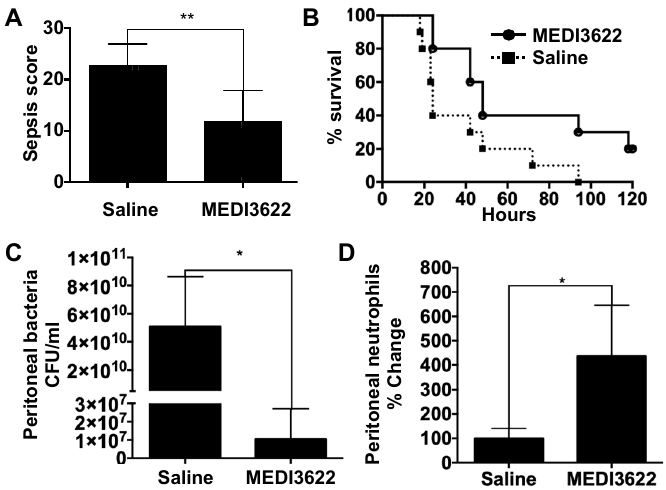
Figure 1. MEDI3622 administration prior to sepsis induction. ( A ) Mice were ip (intraperitoneally) administered MEDI3622 (15 mg / kg) or saline carrier alone (control) and 24 h later subjected to cecal ligation and puncture (CLP) (18G needle). Sepsis severity was assessed at 12 h post-CLP using a murine sepsis scoring system, as described in the Materials and Methods. N = 10 per group, data presented as mean ± standard deviation (SD), ** p < 0.01. ( B ) Survival comparison between the two treatment groups was done by a log-rank test. N = 10 per group, p < 0.05. Bacterial ( C ) and neutrophil ( D ) levels in the peritoneal cavity were determined 24 h after sepsis induction. N = at least 4, data presented as mean±SD, * p < 0.05.